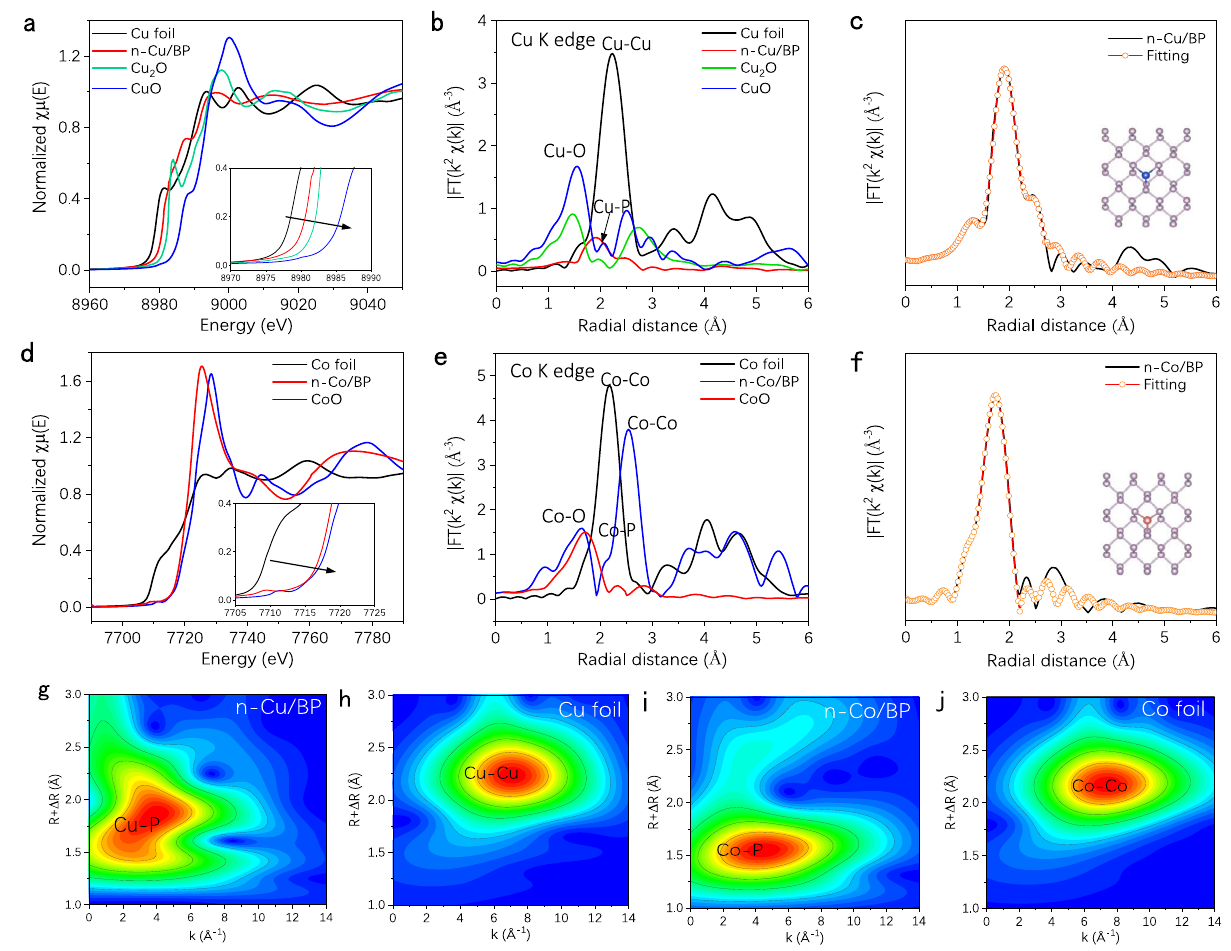
Fig. 2 | Chemical state and coordination information for copper and cobalt SACs. a The normalized Cu K-edge XANES and b FT-EXAFS spectra of n-Cu/BP, Cu foil, Cu 2 O and CuO. c FT-EXAFS fi tting curves of Cu K-edge for n-Cu/BP (inset: structural model of Cu-P 3 ). d The normalized Co K-edge XANES and e FT-EXAFS